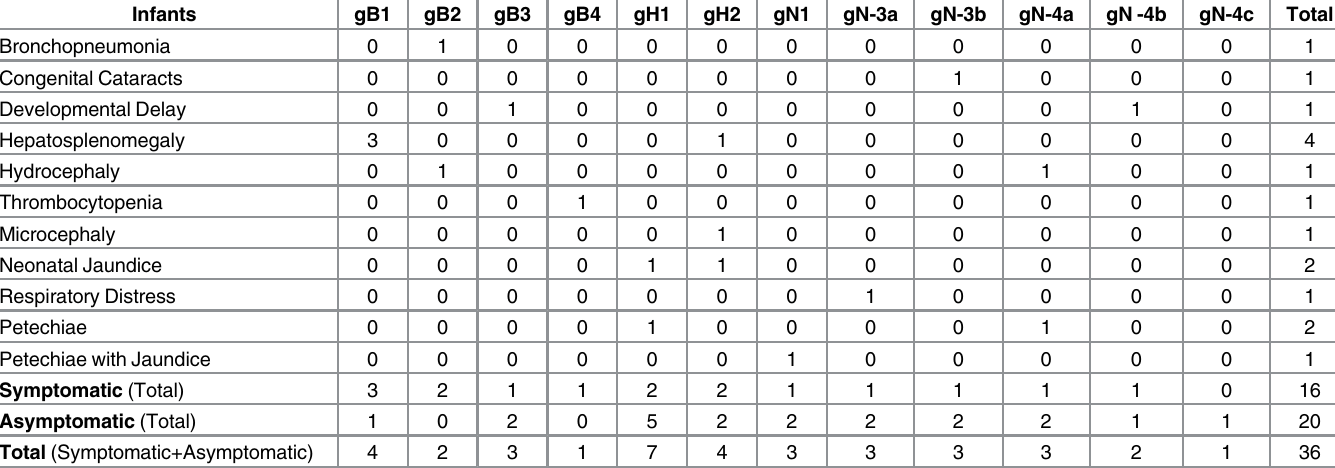
Table 6. Genotype distribution of CMV in neonates born with congenital